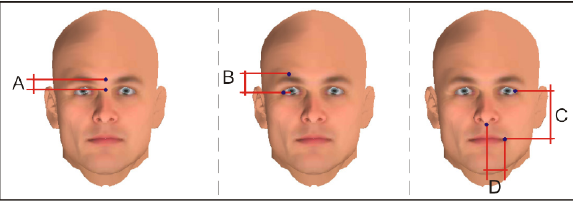
Figure 13. Some measurements in the neutral face.